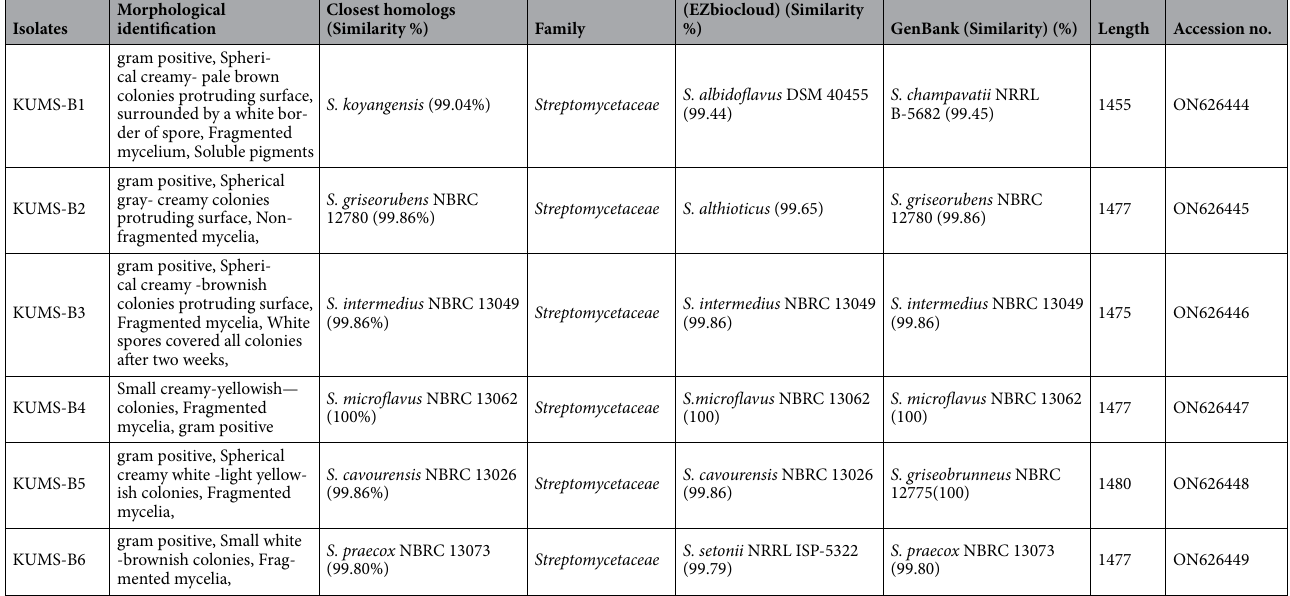
The morphology of spore shape, surface, and spore structure are important criteria for identifying actinobac- teria. The morphology of spore chains and mycelia were also studied using SEM after two weeks growth on ISP2 medium at 28 °C. Scanning electron micrograph of mycelia and spores presenting the spore-chain morphology and spore-surface ornamentation of strains at different magnification are demonstrated in Fig. 3. The SEM results revealed that the aerial mycelia produced spore chains that were cuboid- spiral, cylindrical shaped, the branched and/or spiral or rod-shaped and/or long aerial mycelia and spore chains as demonstrated in Fig. 3. Figure 3 shows spore-chain morphology and spore surface ornamentations of isolates after two weeks of incubation on ISP2 medium at 28 °C. They were clustered of single spores or spore chains. Spores of some actinobacteria had hairy surface and some had rugose or spiny surfaces. Generally, the spores were of oval and ovoid shape and had smooth surface (Fig. 3A), or coarse surfaces (Fig. 3B and C), but globes and rod-shaped spores, or cube shape such as KUMS-B4 (Fig. 3D) were also frequently found. The spores have cylindrical cube- shapes with indenting surfaces, which form in long straight branched chain ornamentations (Fig. 3D). Spores with spiny surface were observed with variable spine sizes (Fig. 3B and C). The spore chain of some strains such as KUMS-B2 and KUMS-B3 have hairy surface. Some are spiny and spiral chain such as KUMS-B2 (Fig. 3B). The spiral or flexuous spore chains were simple, open, loose coils of one to two turns, but some are hairy and in a long straight chain and branched ornamentations (Fig. 3C). Spore of some strains like KUMS-B1 have smooth surface. Strain KUMS-B2 showed a spore chain morphology of exhibiting spiral morphology.